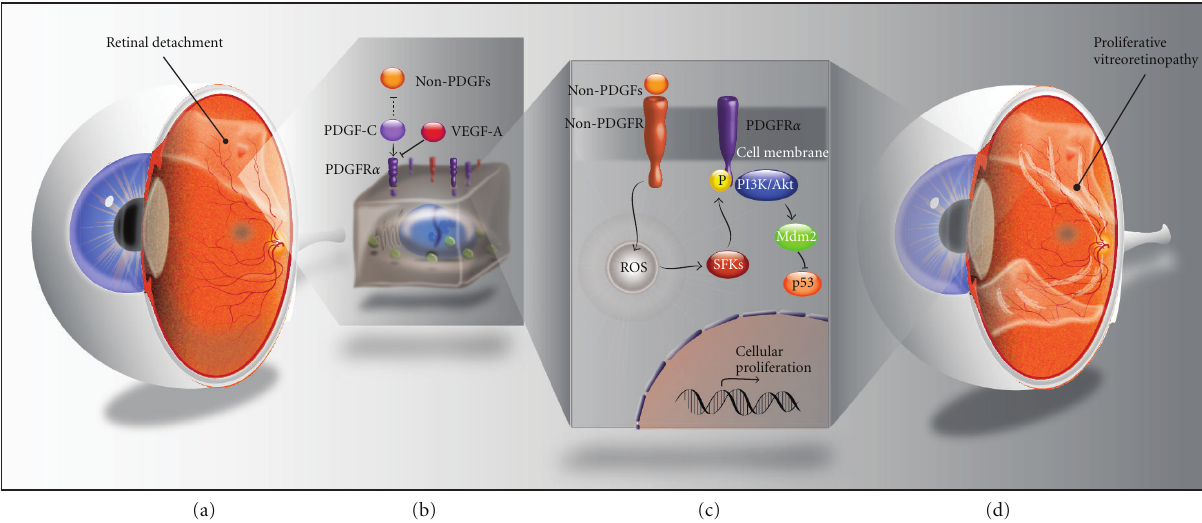
Figure 1: Indirect activation of PDGFR α by non-PDGFs triggers the events leading to proliferative vitreoretinopathy (PVR). A retinal tear or detachment (a) creates an opening via which vitreal growth factors and cytokines interact with intraretinal cells and retinal pigment epithelial (RPE) cells. Vitreal VEGF-A competitively inhibits the binding of platelet-derived growth factors (PDGFs), including the predominant isoform isolated in the vitreous of patients with PVR, PDGF-C, to the receptor PDGFR- α (b). In doing so, VEGF-A prevents direct activation of PDGFR α by PDGFs. Direct activation of PDGFR α promotes rapid clearance of this receptor from the cell surface and subsequent intracellular degradation; this rapid receptor cycling interferes (b) with the ability of non-PDGFs to activate the PDGFR α through an indirect pathway as follows. Non-PDGFs, including basic fibroblast growth factor (bFGF), epidermal growth factor (EGF), insulin, and hepatocyte growth factor (HGF), activate their receptors, which results in an elevation of the level of intracellular reactive oxygen species (ROS), which leads to activation of Src family kinases (SFKs) that promote phosphorylation and activation of PDGFR α (c). This pathway of indirect activation results in persistent PDGFR α signaling and induces prolonged activation of phosphatidylinositol 3-kinase (PI3K)/Akt, which phosphorylates murine double minute (Mdm2), which then suppresses p53 levels (c). This promotes an environment of cell survival, proliferation, organization into a membrane, and subsequent membrane contraction, the processes intrinsic to PVR (d). Therefore, VEGF- A inhibits physiological, direct activation of PDGFR α by PDGFs and favors pathological, persistent, indirect activation of the receptor by non-PDGFs, triggering the events leading to